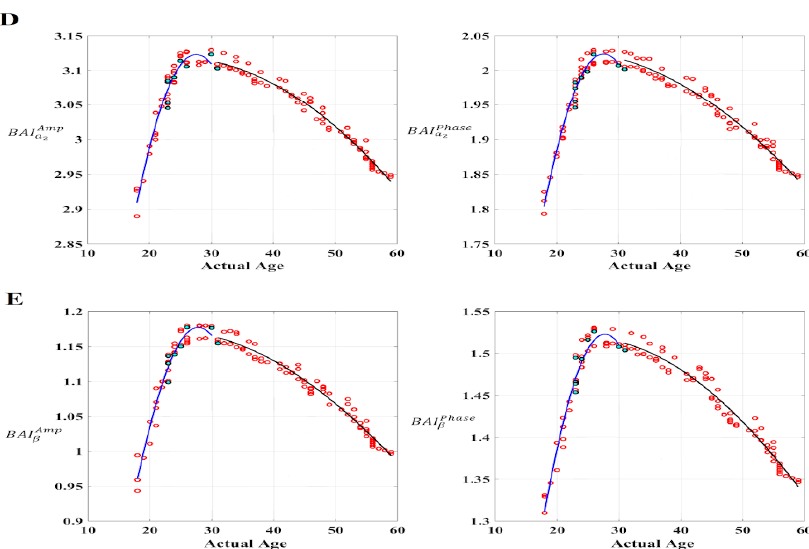
Figure 7. The proposed frequency-dependent brain age index (BAI) is plotted versus actual age. ( A – E ) Frequency-dependent BAIs are independently plotted versus actual age for each modulating frequency from δ to β . The first column refers to amplitude-based BAIs, and the second column refers to phase-based BAIs. For the model selection of BAI curves versus real age, we utilized the coefficient of determination (R). The Gaussian model fits better to the two age-dependent BAI curves ( blue color : 18–30/ black color: 31–60). CTF/ELEKTA MEG systems refer to the original lifespan cohort and the repeat scan cohort, respectively.